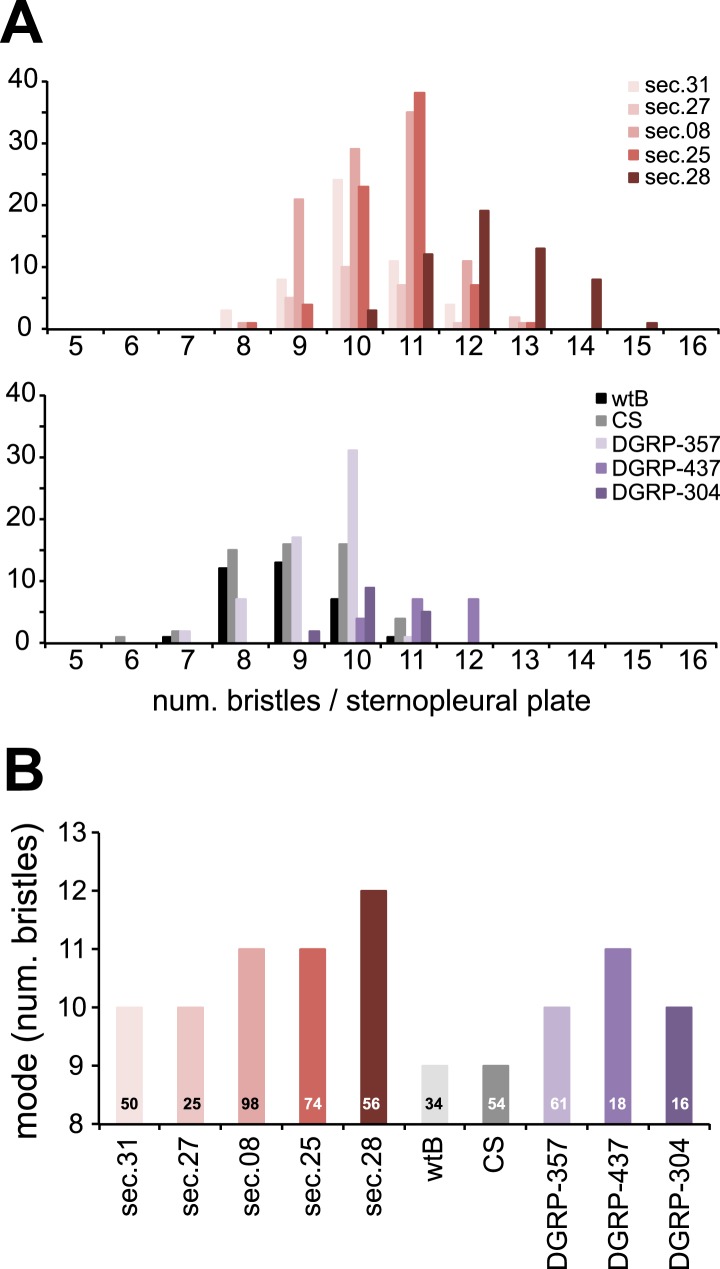
Sensory bristles.(A) Histograms of total (macro and micro quetas) number of bristles per sternopleural plaque and (B) graph of mode (N is indicated for each species) of female D. melanogaster wild-type Berlin (wtB), D. melanogaster Canton-S (CS), D. melanogaster DGRP-357 (DGRP-357), D. melanogaster DGRP-437 (DGRP437), D. melanogaster DGRP-304 (DGRP-304), and D. sechellia (sec) original from Praslin (14021–0248.31 (sec.31) and 14021–0248.08 (sec.08), Seychelles 14021–0248.27 (sec.27)) and Cousin (14021–0248.25 (sec.25) and 14021–0248.28 (sec.28)) islands.